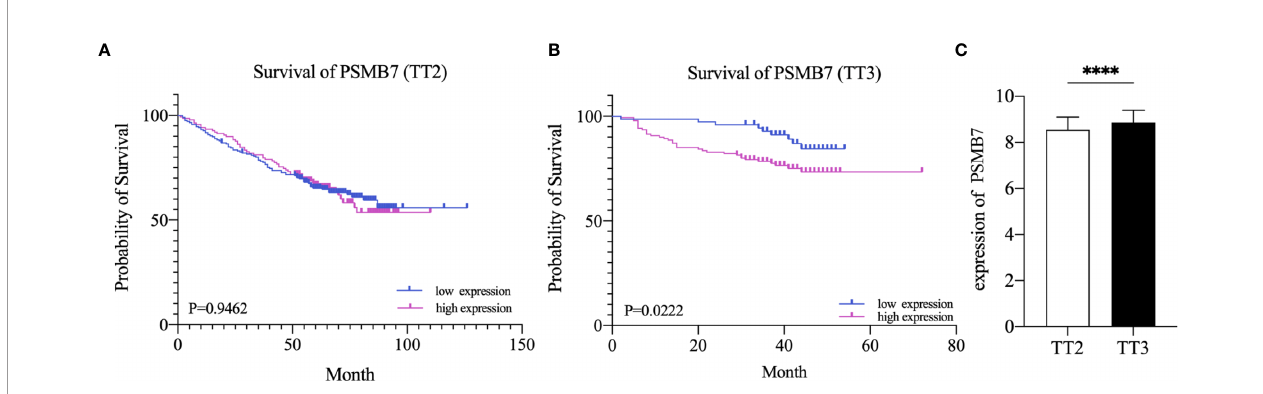
FIGURE 7 | Kaplan-Meier survival curves of NDMM patients. (A) Overall survival of PSMB7 in the TT2 group. (B) Overall survival of PSMB7 in the TT3 group. (C) Expression of PSMB7 in the TT2 and the TT3 group, ****P